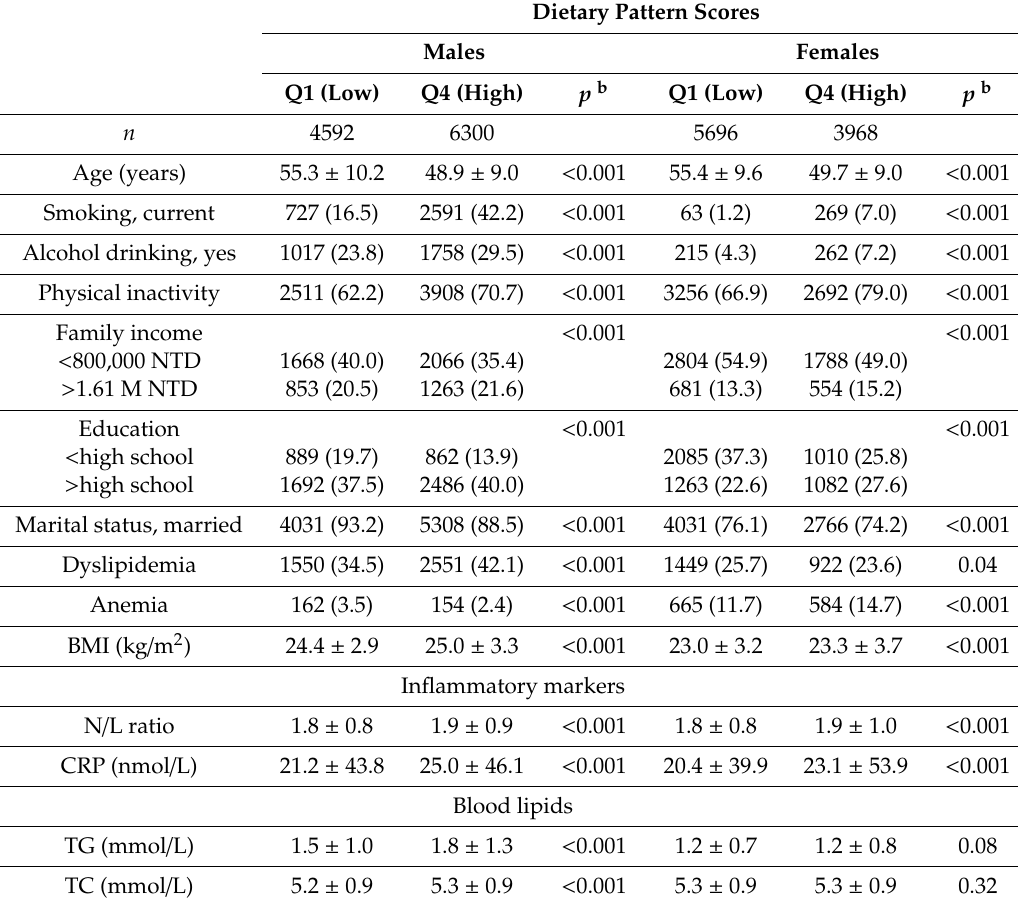
Table 1. Characteristics of the participants across quartiles of inflammatory dietary pattern scores a .